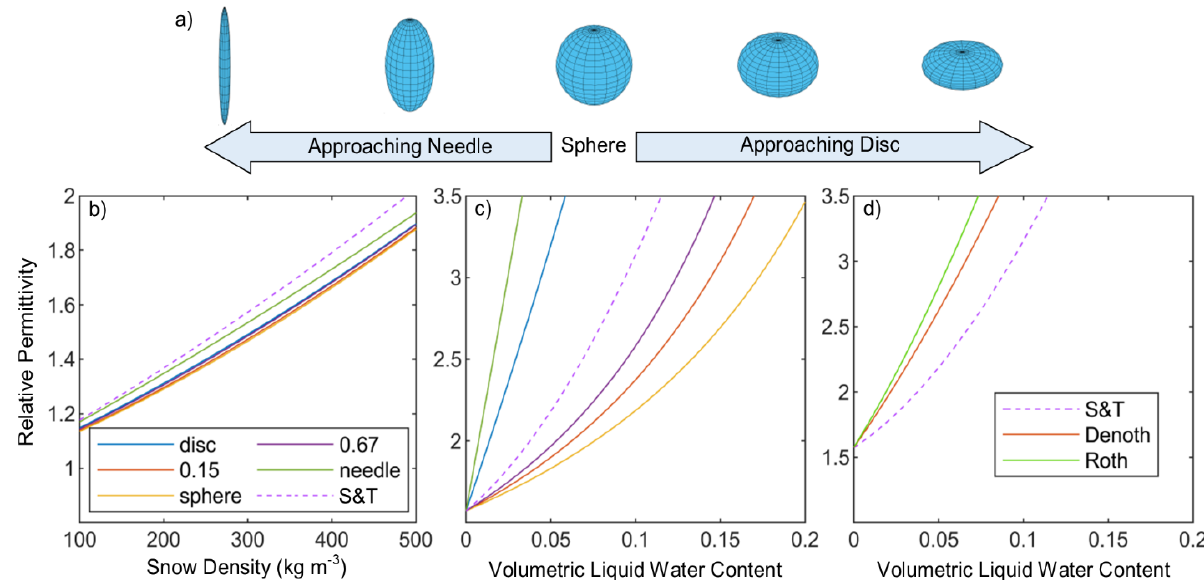
Figure 1. Examples of the Polder and van Santeen [29] formula for various shaped materials. ( a ) Diagrams of the three- dimensional ellipsoids defined by the depolarization factors ( N i ). For the example plots, N 1 is noted in the legend and N 2 = N 3 . ( b ) The Polder and van Santeen [29] model for the relative permittivity as a function of dry snow based on different N i assumptions and the Sihvola and Tiuri [31] equation (S and T) shown for comparison. ( c ) The Polder and van Santeen [29] model for relative permittivity as a function of volumetric liquid water content for snow with a density of 300 kg m − 3 based on different N i assumptions and the Sihvola and Tiuri [31] equation shown for comparison. ( d ) Comparison of Sihvola and Tiuri [31], Denoth et al. [26], and Roth et al. [32] equations for volumetric liquid water content of snow with a density of 300 kg m − 3 . Table 1. Common equations that relate snow density ( ρ s , kg m − 3 ) and volumetric liquid water content ( θ w , cm cm − 3 ) to the relative permittivity ( k ) at low frequencies (0.01 – 1.5 GHz).